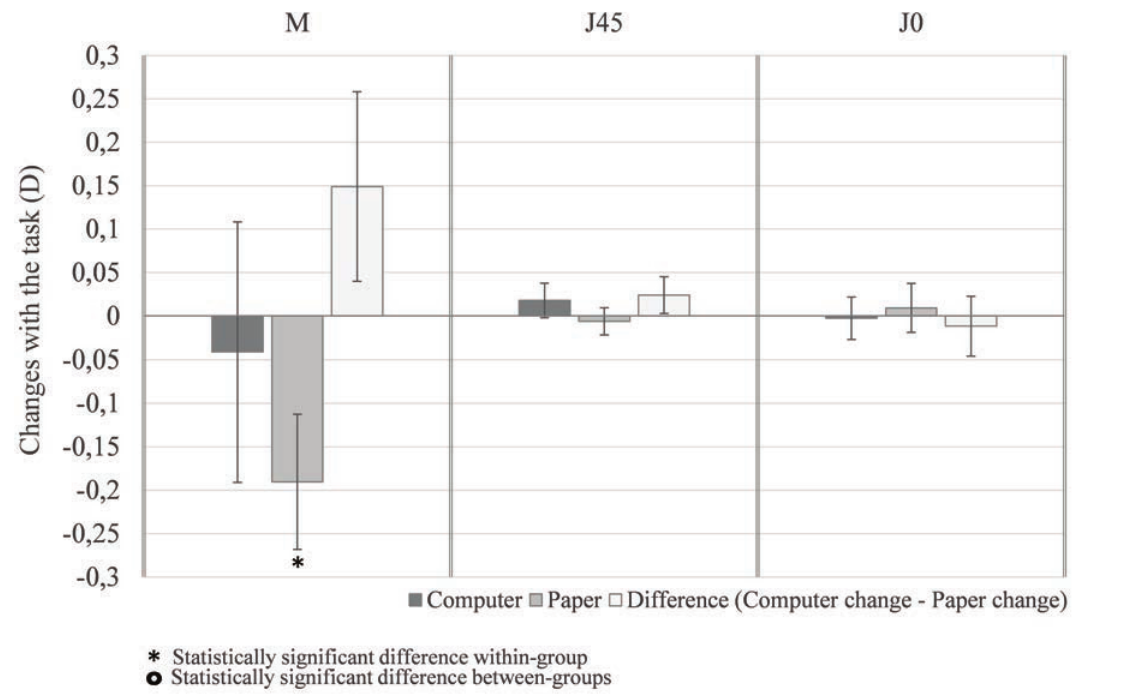
Figure 3. Changes of vector components of ocular astigmatism J45 and J0 and spherical equivalent of computer and paper group and the differences between their changes, with 95%-confidence-interval error bars. There were no statistically significant changes of astigmatism J45 and J0. Spherical equivalent became more negative with statistically significant change in the paper group. The changes found in both groups were not statistically significantly